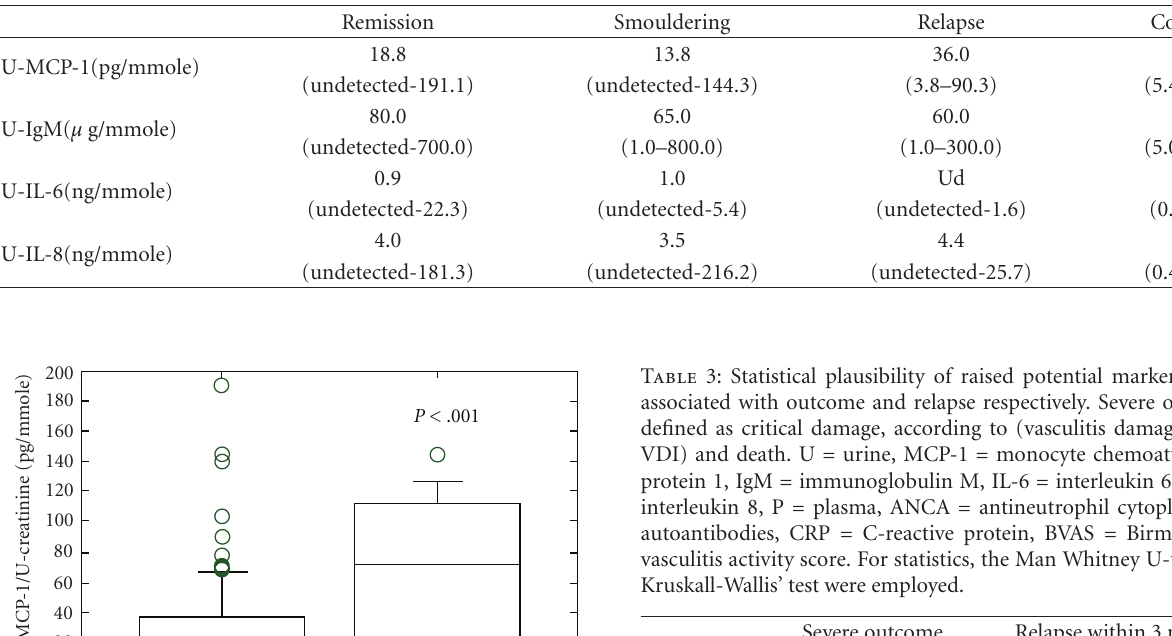
Table 2: Urine levels of MCP-1, IgM, IL-6 and IL-8. MCP-1 = monocyte chemoattractant protein 1, IgM = immunoglobulin M, IL-6 = interleukin 6, IL-8 = interleukin 8. All data are expressed in relation to U-creatinine. Controls = healthy blood donors.